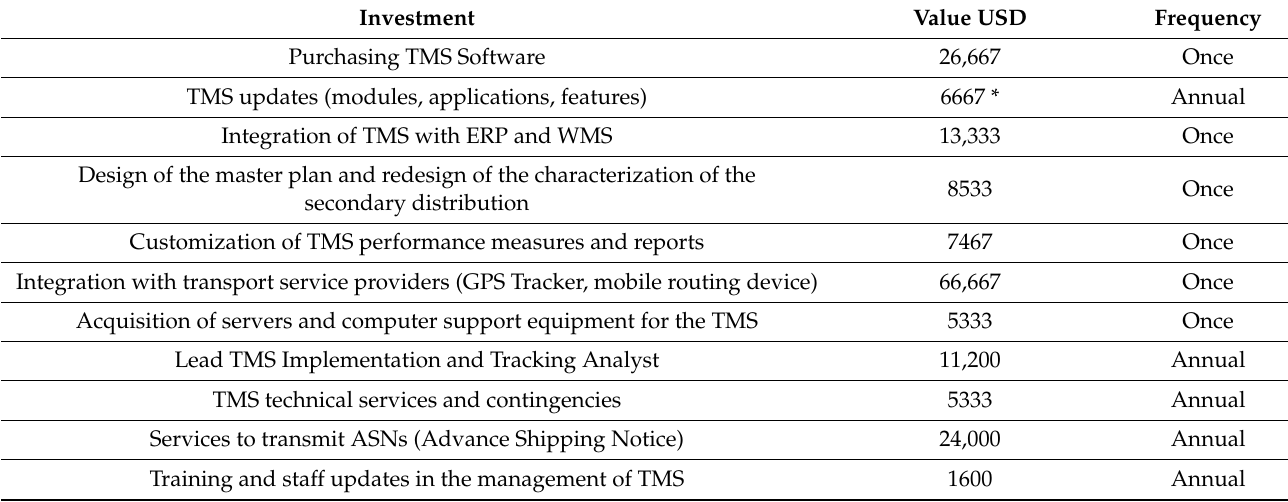
Table 14. Investments for the implementation of a